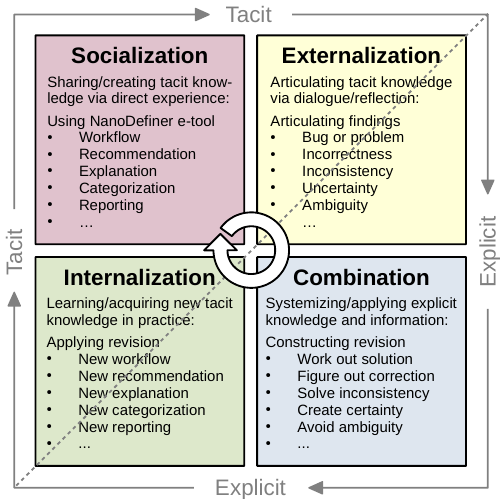
Figure 4. Knowledge management during the development of the NanoDefiner e-tool. Revision cycles were oriented towards the Socialization (purple), Externalization (yellow), Combination (blue), Internalization (green) model of knowledge creation, adapted from